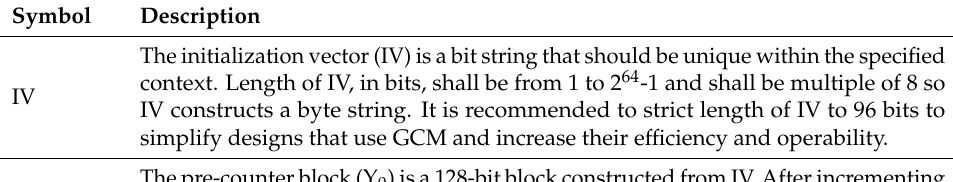
Table 1. The symbols and processes used in the GCM authentication